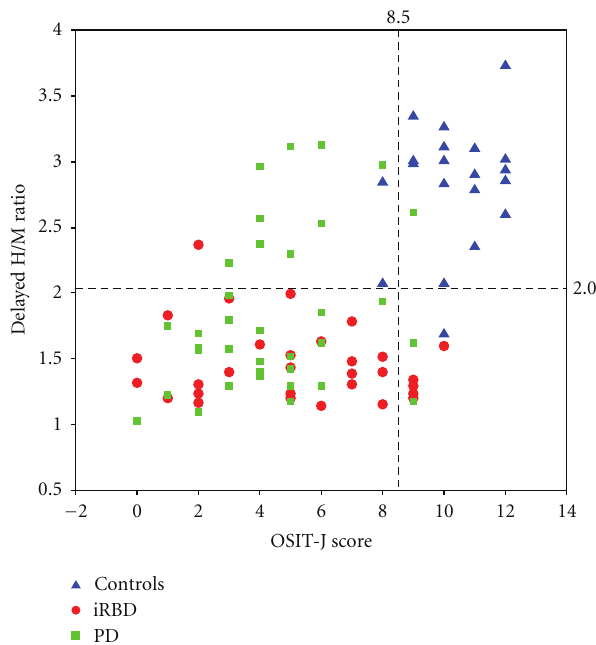
Figure 2: The relation between the OSIT-J score and the delayed H/M ratio of 123 I-MIBG uptake in patients with iRBD (the red circle), PD (the green square), and controls (the blue triangle). Broken line (vertical): cut-o ff value set at 8.5 by OSIT-J to distin- guish between iRBD or PD and controls. Broken line (horizontal): cut-o ff value set at 2.03 by 123 I-MIBG to distinguish between iRBD or PD and controls. OSIT-J: Odor Stick Identification Test for Japanese; H/M: heart-to-mediastinum; 123 I-MIBG: 123 I- metaiodobenzylguanidine; OSAS: obstructive sleep apnea syn- drome; iRBD: idiopathic rapid eye movement behavior disorder; PD: Parkinson’s